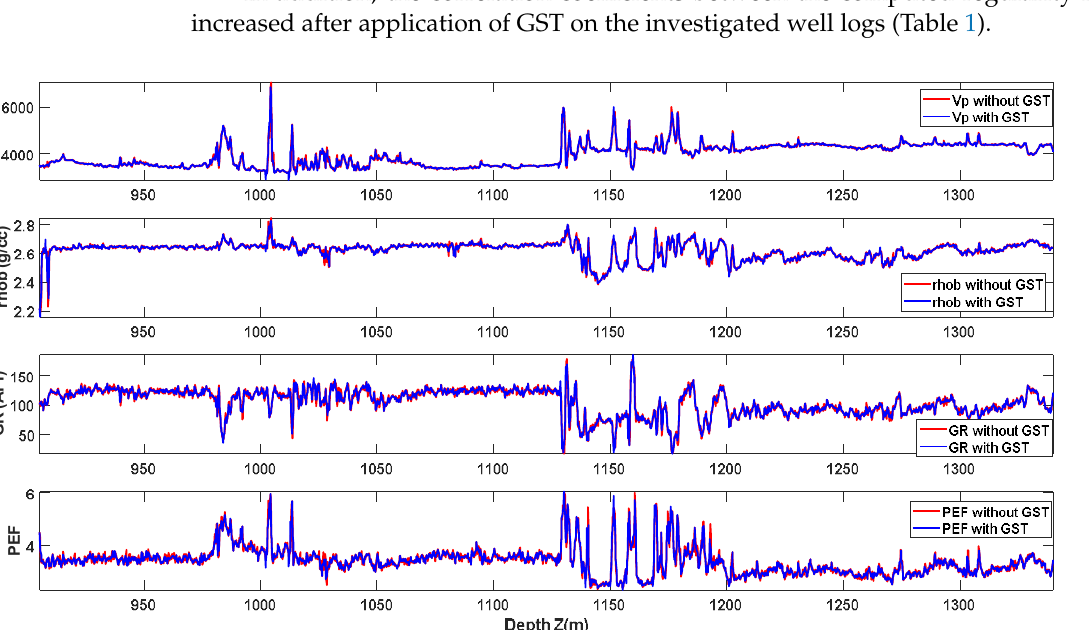
Figure 5. Physical properties measured within the depth interval (905–1340 m) in borehole W1: the raw data (in red) and the data processed by the GST (in blue) [35]. Table 1. Correlation coefficients between the regularity profiles derived from the analyzed well logs (without GST | with